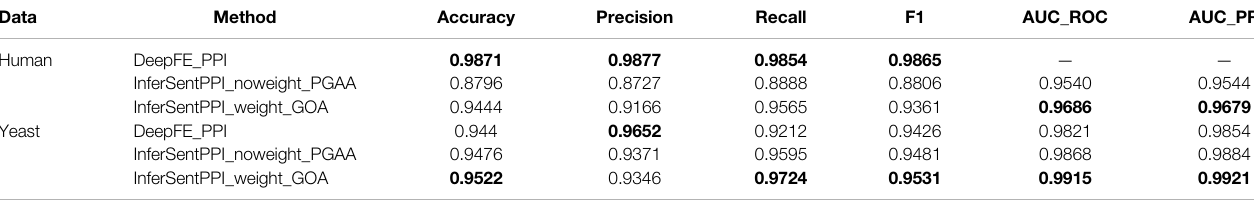
TABLE 5 | Performance comparison of three methods on the DIP yeast and HPRD human datasets.